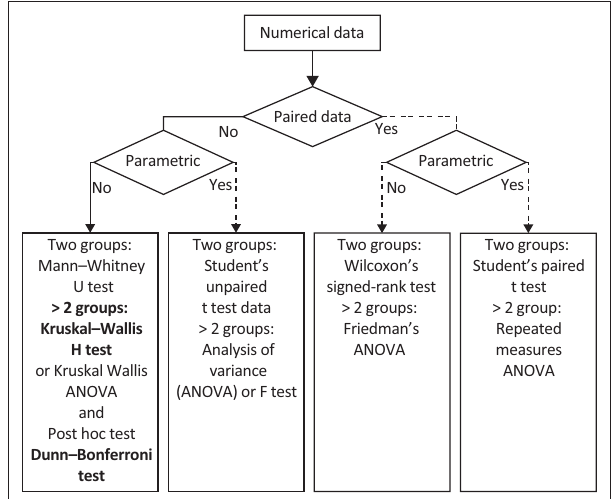
FIGURE 8: Statistical tests to compare numerical data for difference – with own